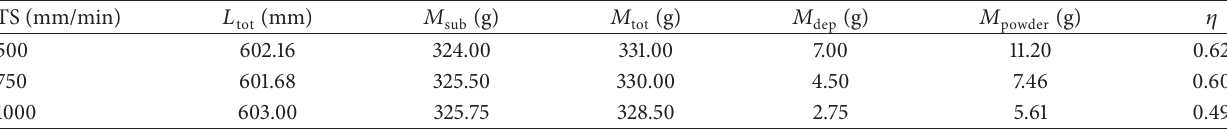
Table 3: Average deposition efficiency 𝜂 at different translation speeds.